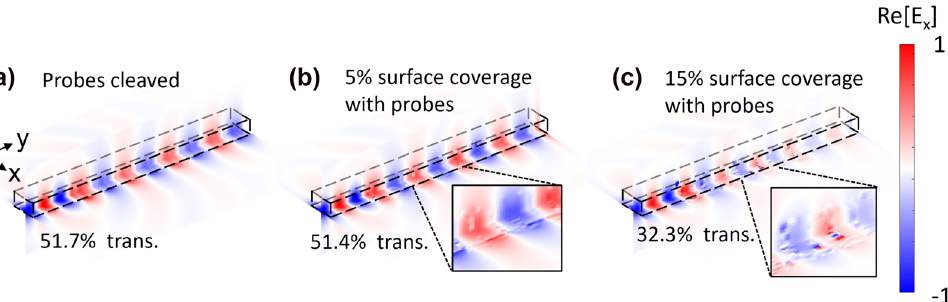
mode propagating through half-wavelength silicon waveguide grating structure. Figure 4: Electric field snapshots of the fundamental TE 0 The half-wavelength waveguide grating is surrounded by deionized water with refractive index of 1.333. The waveguide grating section has ). The real part of the electric field in the x – y dimension and y – z 220 nm thickness, 500 nm width, and duty cycle of 250 nm ( = 0 . 15 𝜆 c dimension is shown in (a) when the probes were cleaved, (b) when the probes cover 5% of the silicon surface, (c) when the probes cover 15% of the silicon